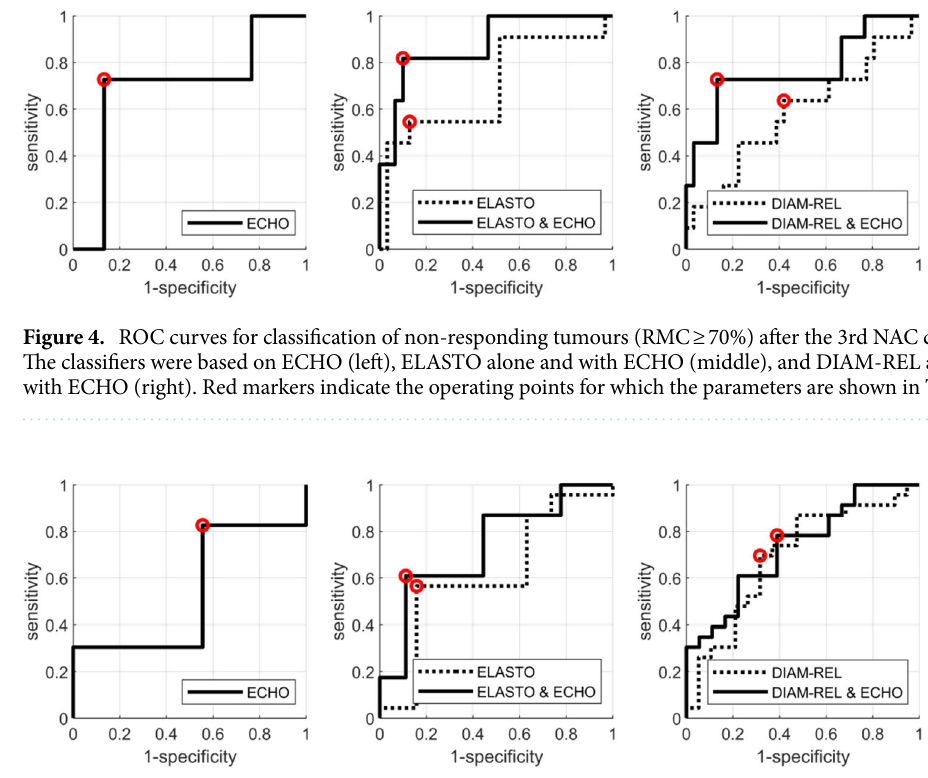
Figure 5. ROC curves for classification of responding tumours (RMC ≤ 30%) after the 3rd NAC course. The classifiers were based on ECHO (left), ELASTO alone and with ECHO (middle), and DIAM-REL alone and with ECHO (right). Red markers indicate the operating points for which the parameters are shown in Table